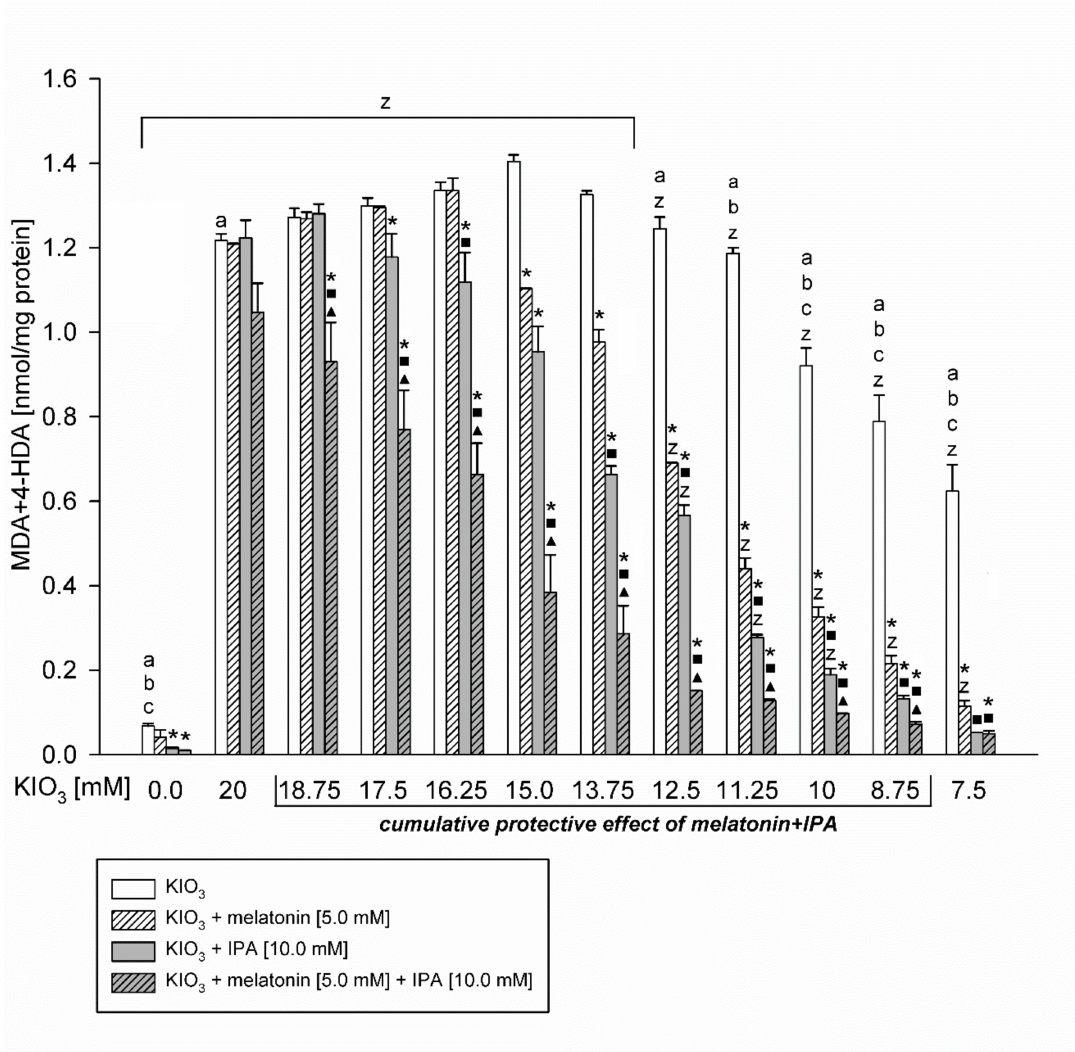
Figure 2. Lipid peroxidation, measured as MDA + 4-HDA level, in porcine thyroid homogenates, incubated in the presence of KIO 3 (20; 18.75; 17.5; 16.25; 15; 13.75; 12.5; 11.25; 10; 8.75; 7.5; 0.0 mM) (white bars), or KIO 3 + melatonin [5 mM] (striped bars), or KIO 3 + IPA [10 mM] (grey bars), or KIO 3 + melatonin [5 mM] + IPA [10 mM] (striped grey bars). *— p < 0.05 vs. KIO 3 . a— p < 0.05 vs. KIO 3 [15 mM]. b— p < 0.05 vs. KIO 3 [16.25 mM]. c— p < 0.05 vs. KIO 3 [13.75 mM]. z— p < 0.05 vs. respective control. (cid:4) — p < 0.05 vs. KIO 3 in the same concentration + melatonin [5 mM]. (cid:78) — p < 0.05 vs. KIO 3 in the same concentration + IPA [10 mM]